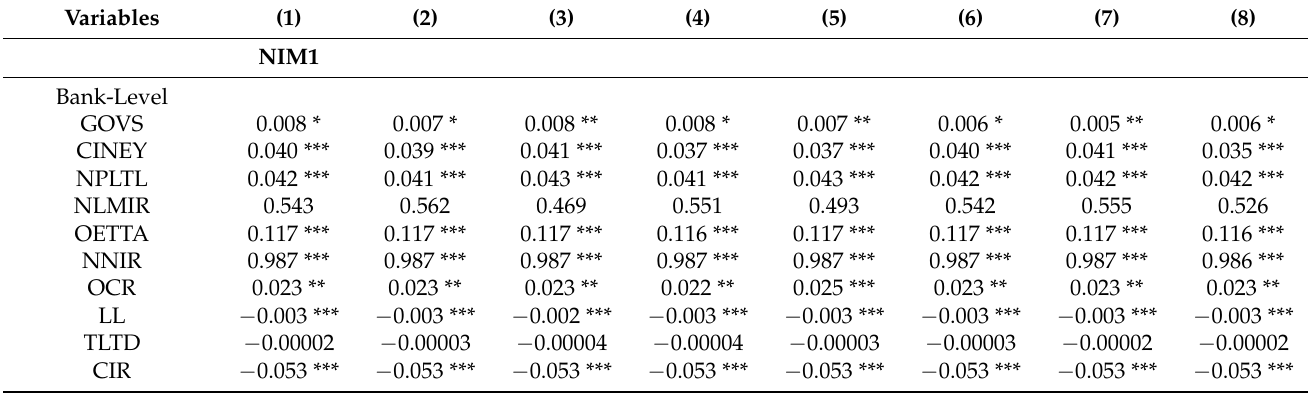
Table 9. Dropping Russia from the whole